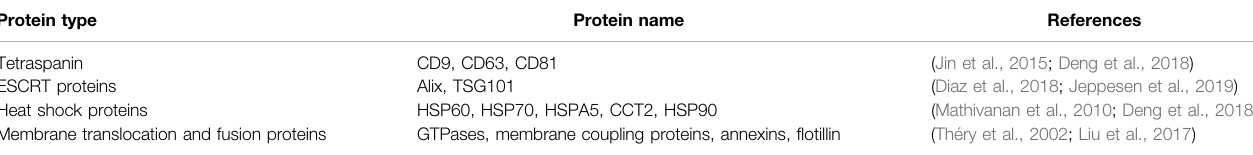
TABLE 1 | Biomarkers of macrophage-derived